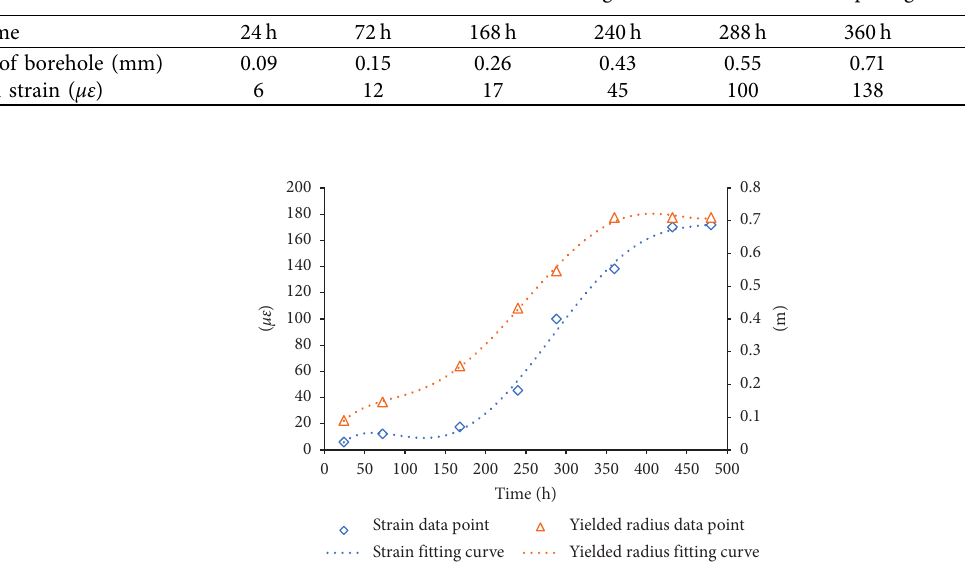
Figure 14: Strain versus borehole spacing. Table 4: Statistics of strain versus time after drilling, borehole diameter, and spacing.